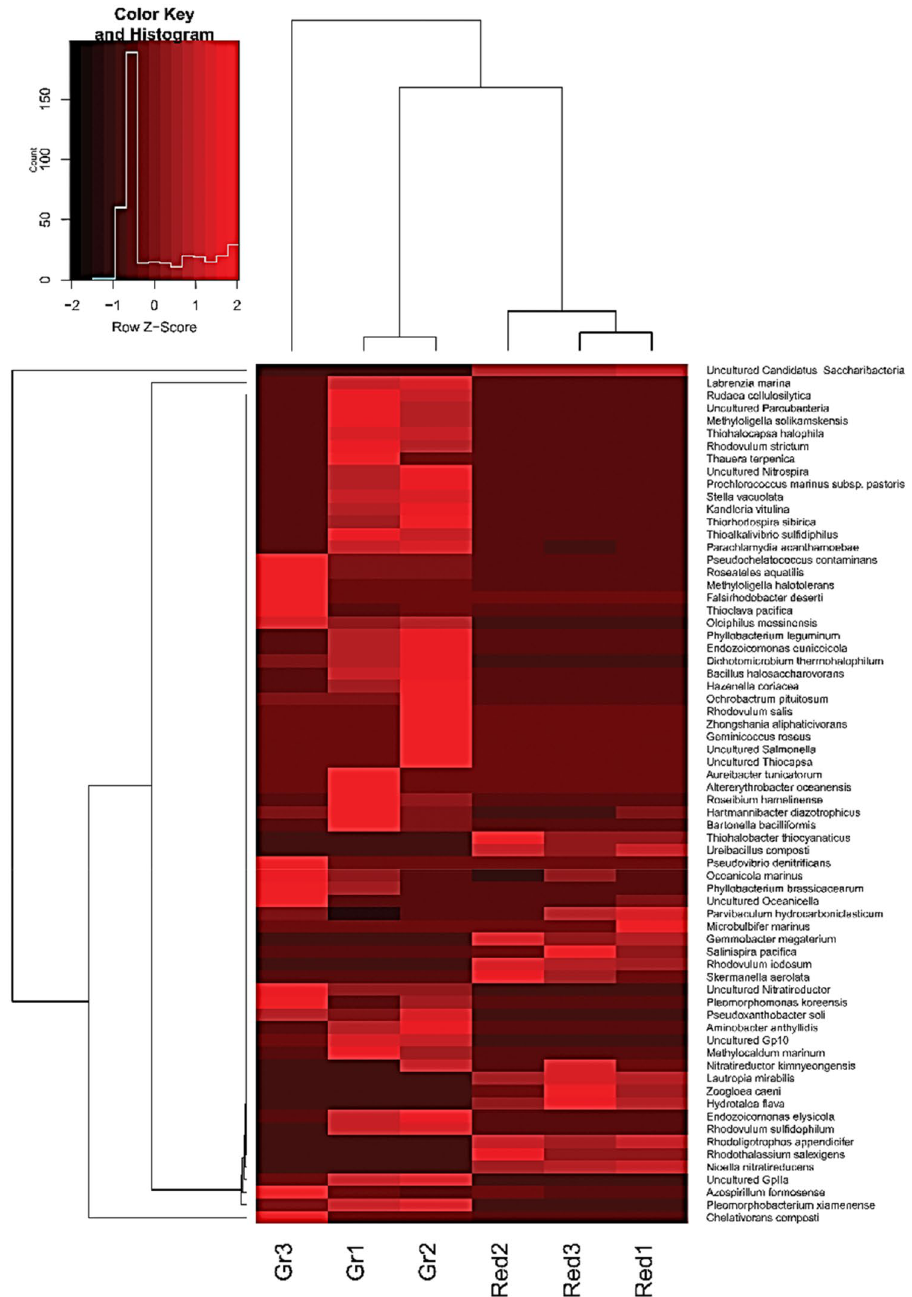
Figure 5. Complete linkage clustering-based heatmap for triplet sample abundance in Gelliodes pumila and Cliona lobata sponges. Heat map of dendrogram ( y -axis) inferred from complete linkage clustering-based species abundance values of all samples containing 68 non-redundant species. The x -axis shows triplicate samples of each of the sponge